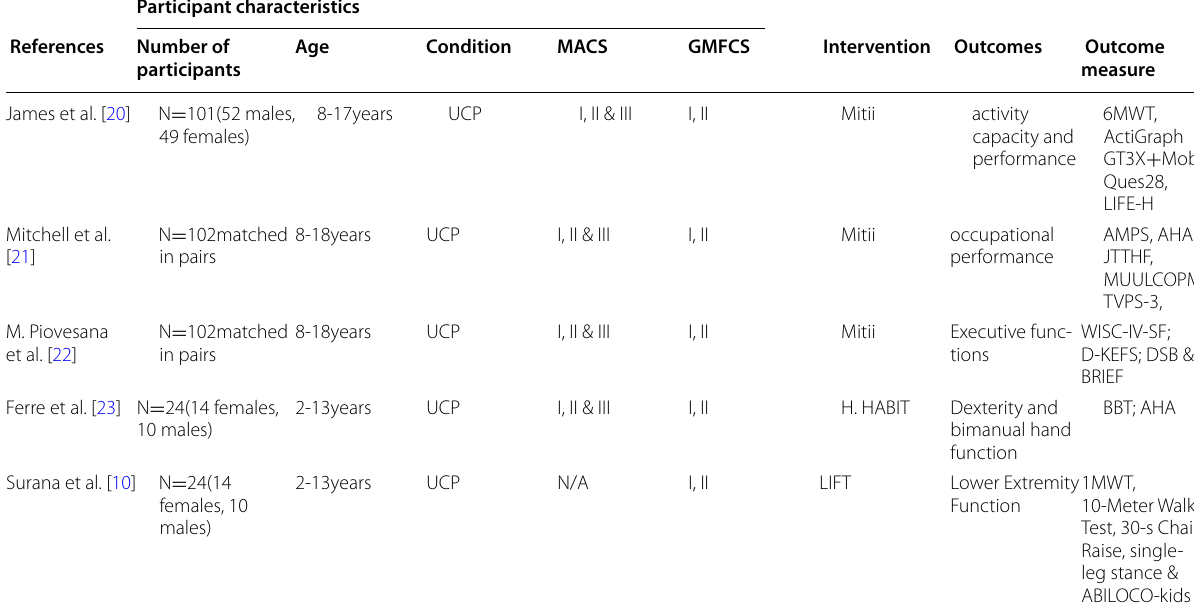
Table 2 Characteristics of the included studies Participant